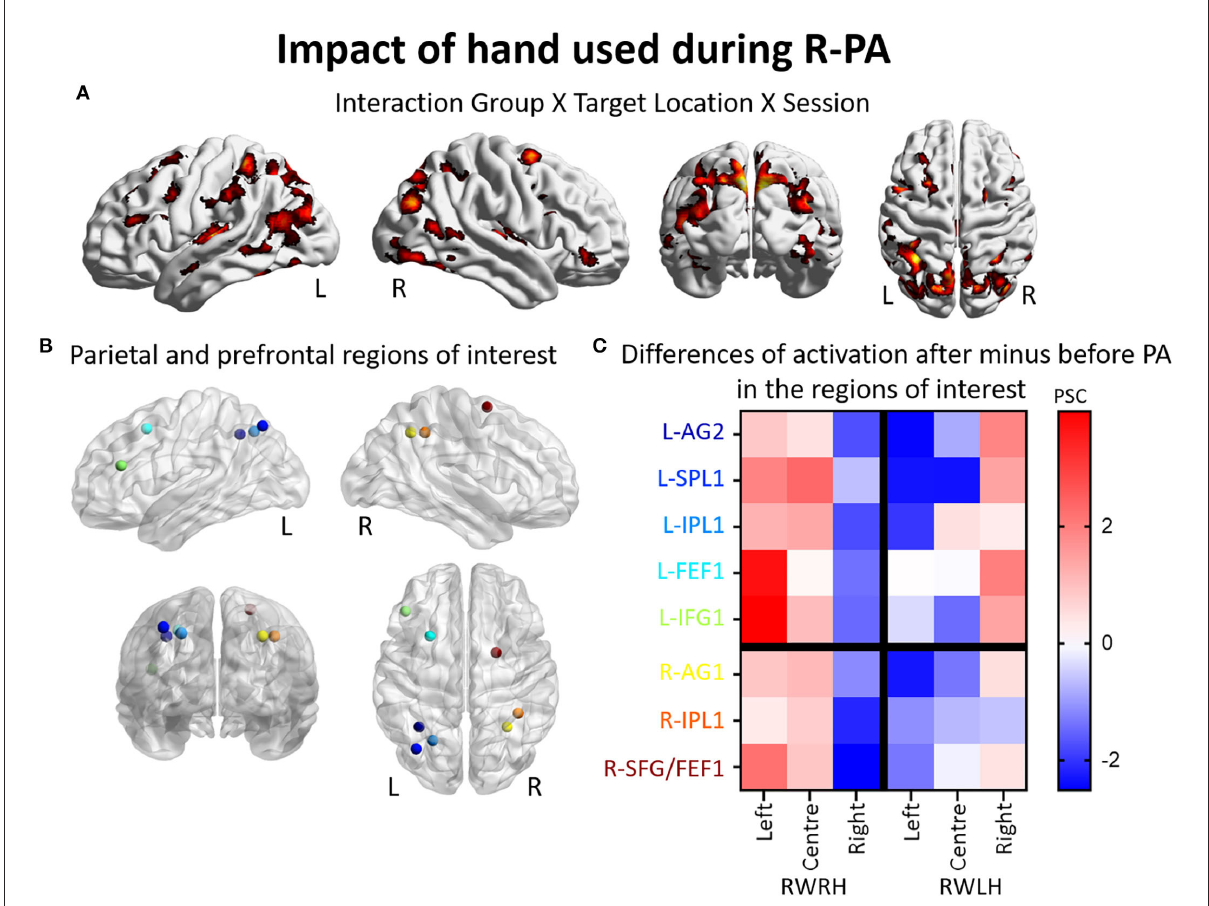
FIGURE2 Impact of the hand used during R-PA on the reshaping of visuo-spatial representations. Modulation of brain activation as revealed by the ANOVA including the groups RWRH and RWLH. (A ) Surface renderings of significant brain activation in the interaction between the factors Group (RWRH, RWLH) x Target location (left, center, right) x Session (pre, post), from left to right: lateral views of the left and right hemisphere, view from the back and the top. All maps are thresholded at p < 0.05, cluster extent k > 66. (B) Spheres located on the peaks of activation clusters in the parietal and prefrontal regions. Lateral views of the left and right hemispheres, above the back and top views. Color code denotes names of the regions, as indicated on the y -axis in C. (C) Differences of activation in percent signal change, after minus before PA, for each group (RWRH and RWLH) and each target position (left, center, and right). AG, angular gyrus; FEF, frontal eye field; IFG, inferior frontal gyrus; IPL, inferior parietal gyrus; L, left; PSC, percent signal change; R, right hemisphere; SFG, superior frontal gyrus; SMG, supramarginal gyrus; SPL, superior parietal